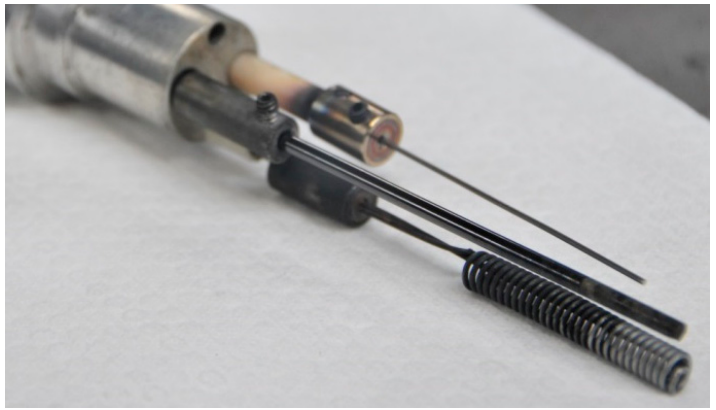
Figure 2. Three-electrode set up (iridium wire as the working electrode; glassy carbon as the pseudo reference electrode and molybdenum coil as the counter electrode).